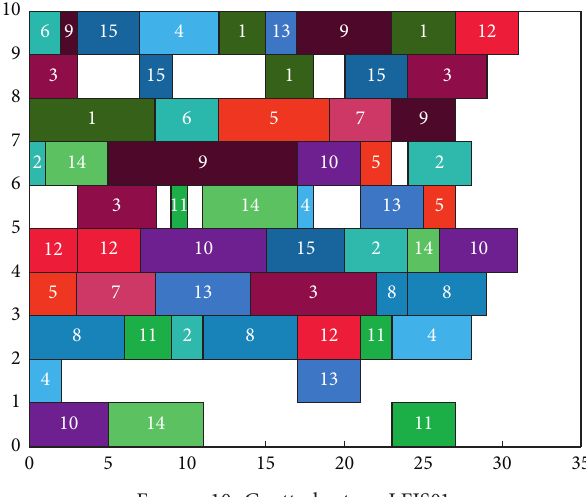
Figure 10: Gantt chart on LFJS01.